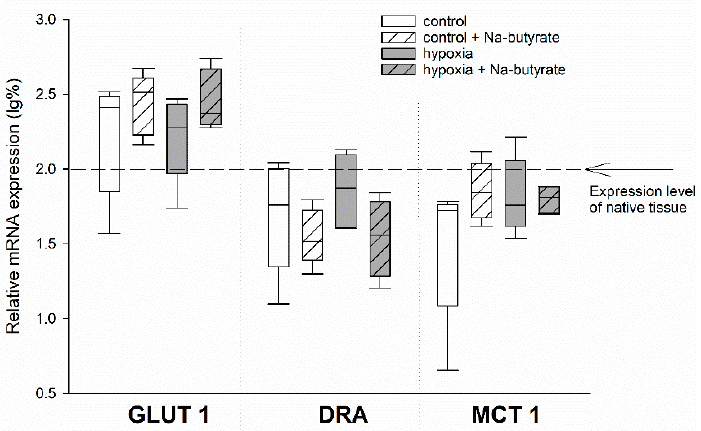
Figure 3. mRNA expression levels in the epithelia incubated in the Ussing chamber under 100% (white boxes) or 1% (grey boxes) O 2 gassing with (hatched boxes) or without 50 mM Na-butyrate in the buffer solution. The expression levels were calculated relative to those measured in native tissues that were not incubated in the Ussing chamber (indicated by the dashed line). Boxes represent the median ± 10th, 25th, 75th and 90th percentile, N = 5 (n = 20). There were no significant differences.